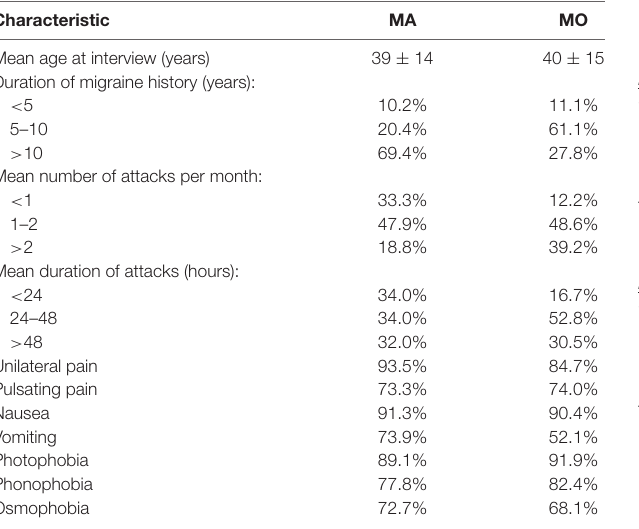
TABLE 1 | Clinical description of the migraine patients.